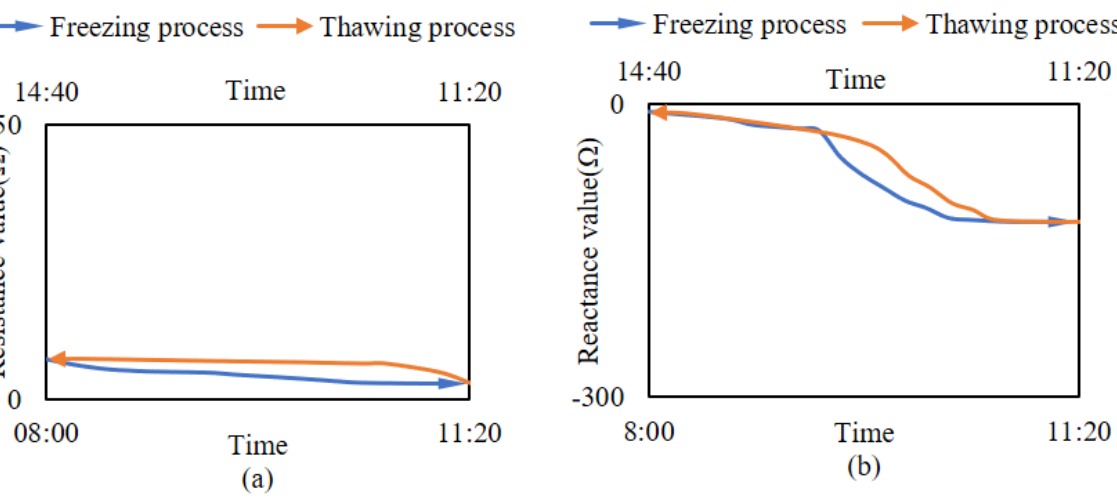
Figure 9. Changes in the impedance of the simulated branches during freeze-thaw cycles. ( a ) The variation of the resistance component. ( b ) The variation of reactance components.